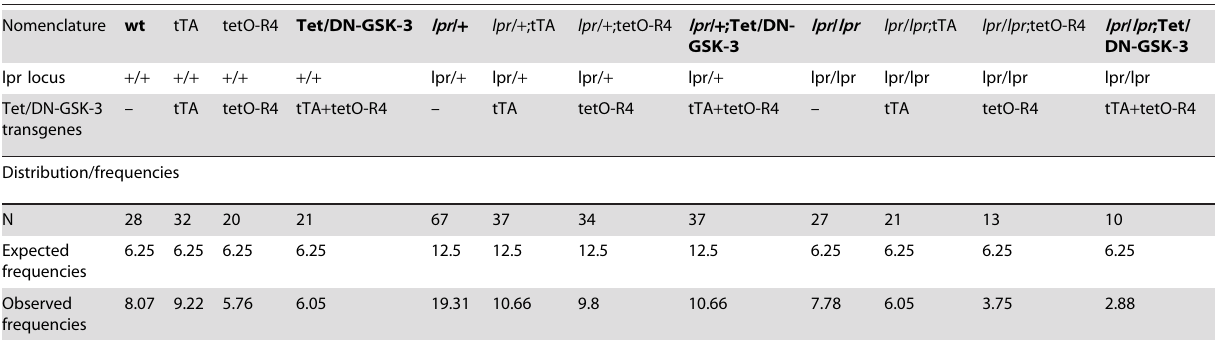
Table 1. Genotype